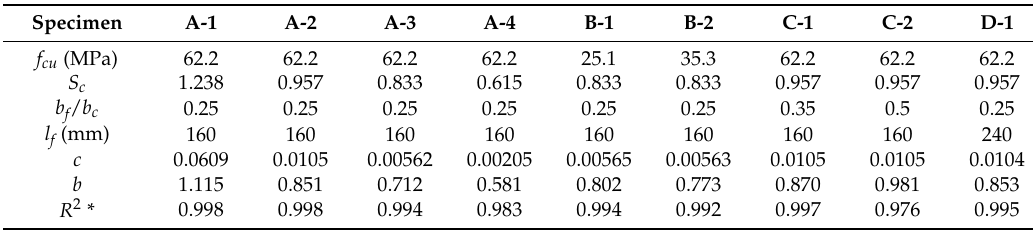
Figure 6. The relationship between K ft and load cycles ( n ). Table 2. Fitting results of c and b .